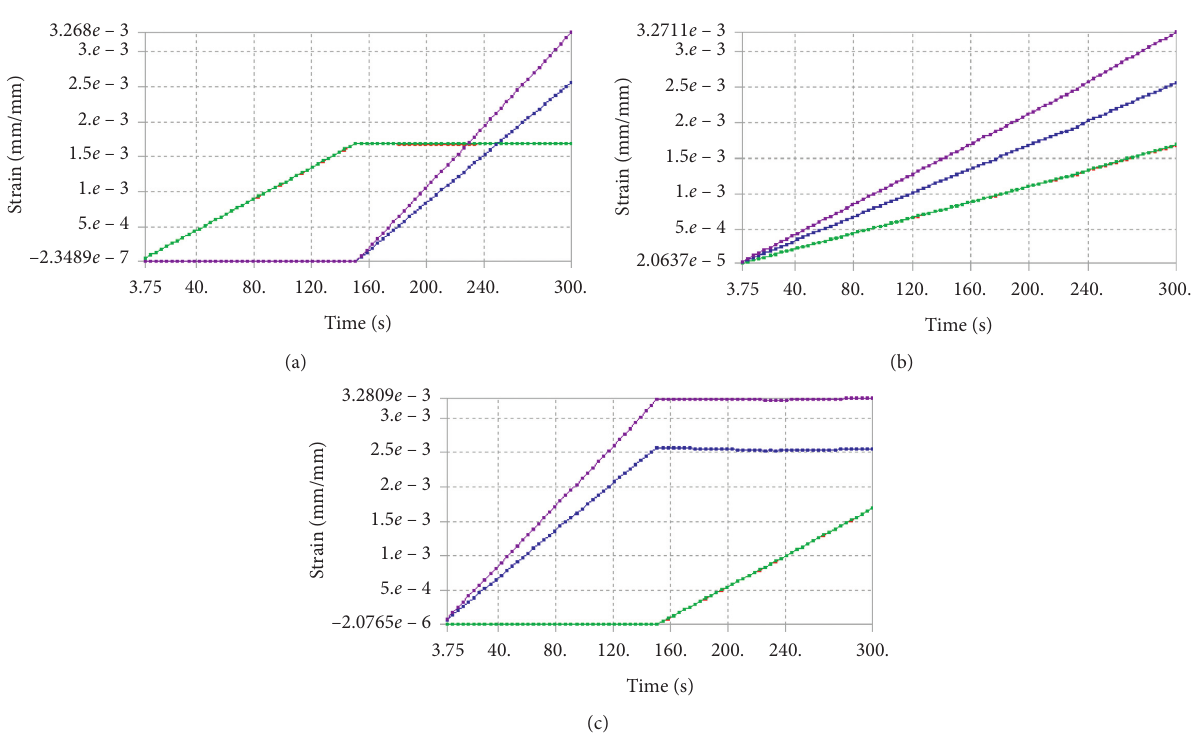
Figure 14: ε c of strain paths A (a), B (b), and C (c). Note. The green and red lines represent the maximum and minimum values of z and θ z normal stress, respectively. The purple and blue lines represent the maximum and minimum values of shear stress,